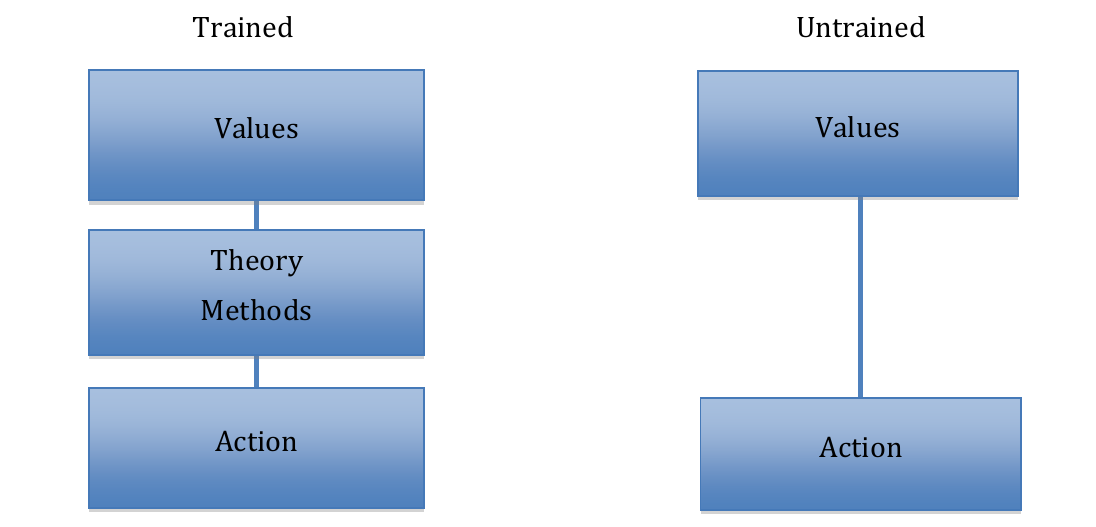
Figure 1. The relationship between values and action (Storø,